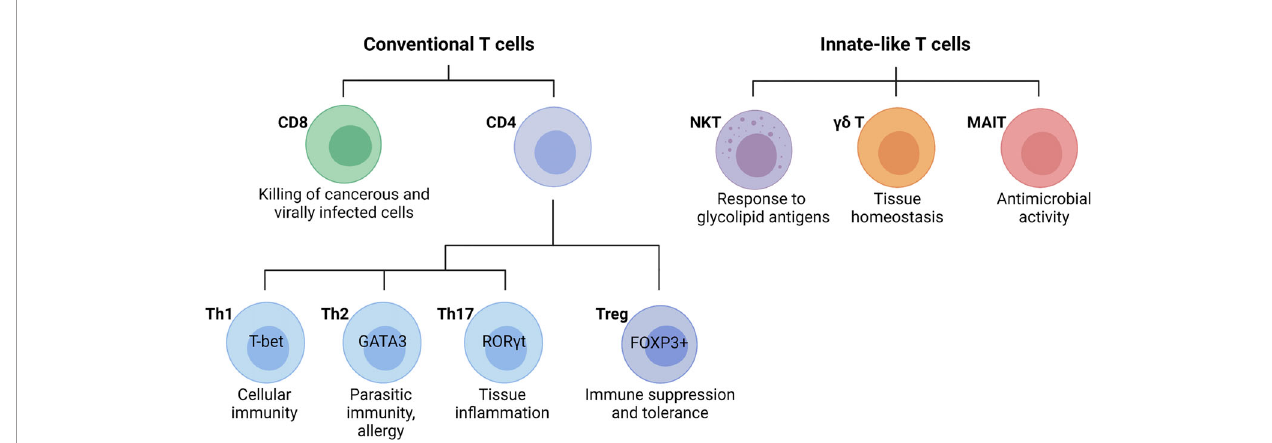
FIGURE 3 | Main T cell subsets and their functions. Conventional T cells are broadly grouped into CD8 and CD4 T cell subsets with diverse functions during an immune response. In general, CD8 cytotoxic T cells directly kill cancerous or infected cells, while CD4 T cells regulate the immune response to a particular antigen. CD4 T cells can be classi fi ed as T helper (Th) cells or regulatory T cells (Tregs). Differentiated CD4 T cell subsets are marked by the expression of the lineage-speci fi c transcription factors T-bet (Th1), GATA3 (Th2), ROR g t (Th17), and FOXP3 (Tregs), which are critical for their differentiation and function. Innate-like T cells are a highly diverse group of cells including natural killer T (NKT) cells, gamma delta ( gd ) T cells, or mucosal-associated invariant T (MAIT) cells. (Created with